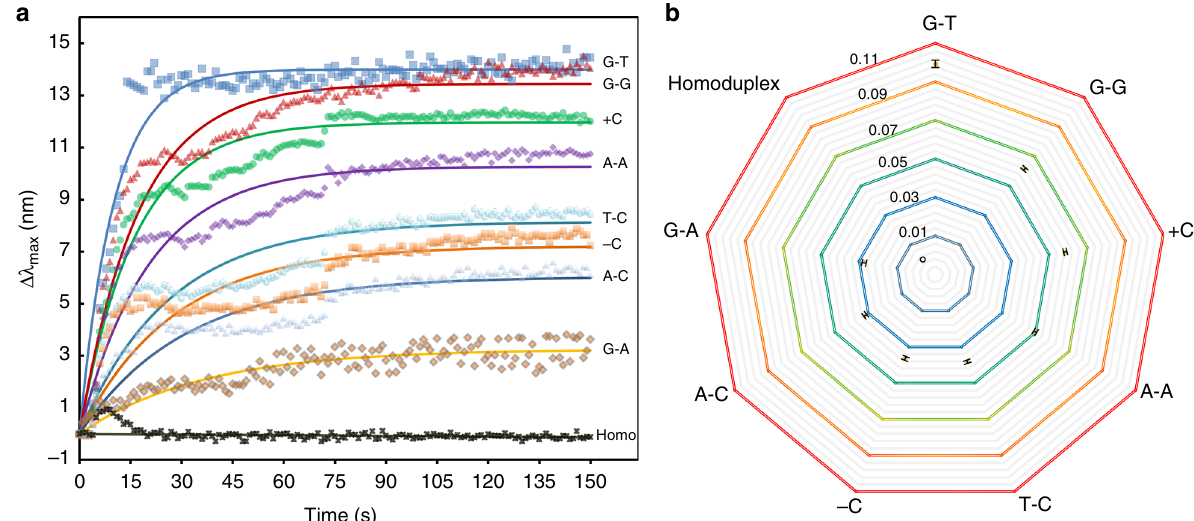
Fig. 3 Identi fi able detection of the eight single point mutations. a Real-time monitoring of MutS binding to each mutant DNA and a homoduplex. b Replotting of rate constants of interactions between MutS and each point mutation. Error bars represent mean ± S.E.M. All experiments were performed in triplicate. Source data are provided as a Source Data fi le